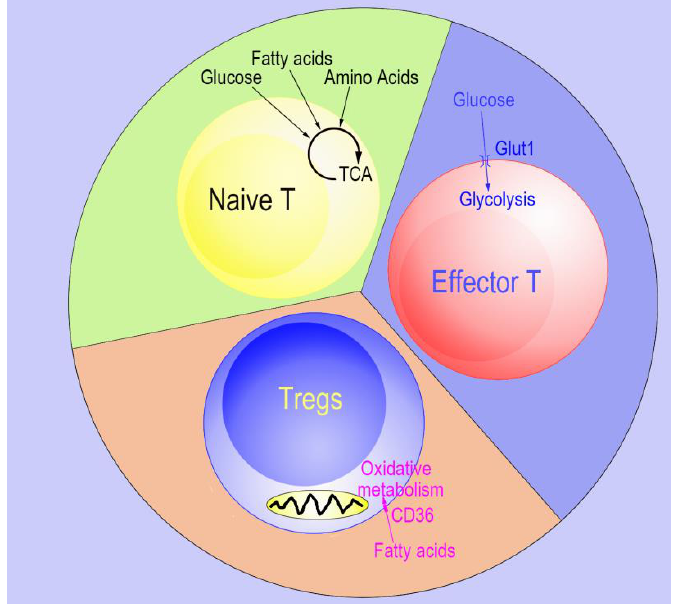
Figure 1. Model of energy usage by naïve T, effector T, and Regulatory T cells (Tregs). Naïve T cells use glucose, fatty acids, and amino acids as their energy source. Effector T cells have higher energy efficiency and use glucose as their primary energy source. In contrast, the glucose transporter 1 is absent in Tregs and Tregs use fatty-acid oxidation (FAO) as their main energy source.